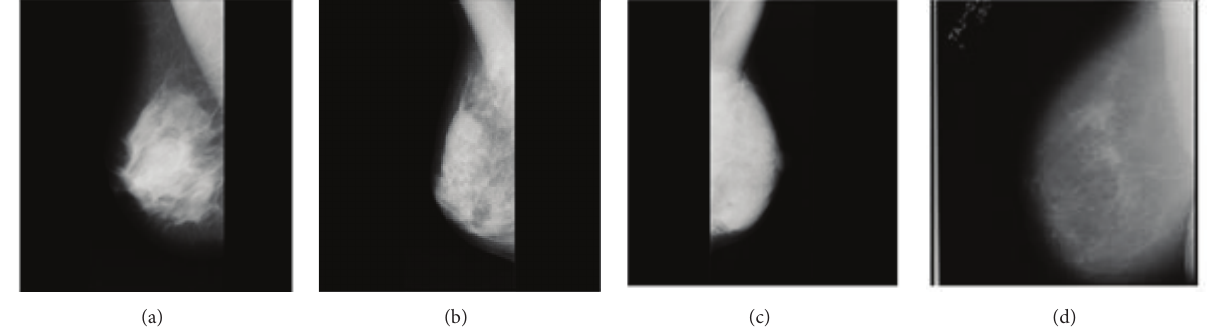
Figure 4: Host image: (a) mdb001, (b) mdb017, (c) mdb054, and (d) mdb153.